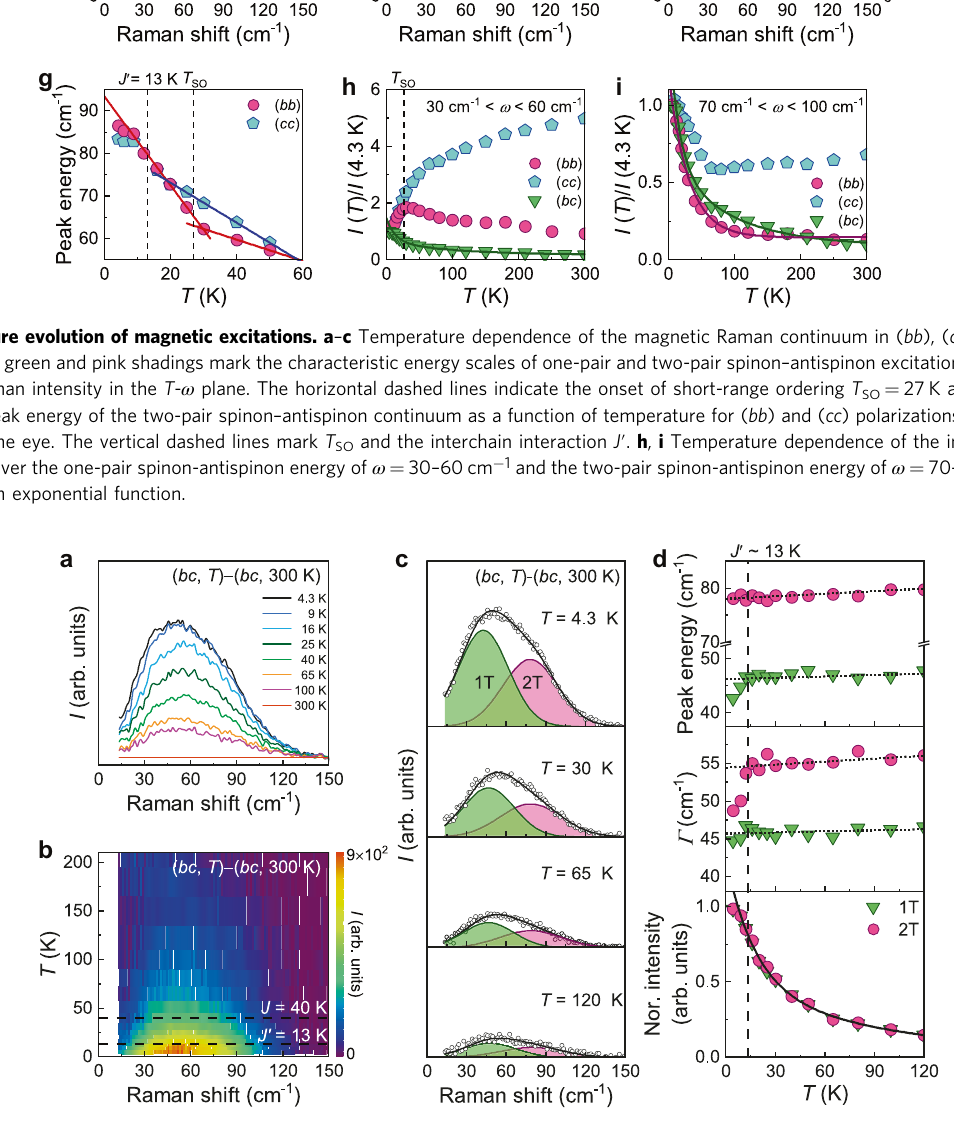
Fig. 4 Temperature evolution of one and two triplons in ( bc ) polarization. a Triplon signals in ( bc ) channel after subtraction of the T = 300 K spectrum. b Color plot of the subtracted triplon excitations in the T - ω plane. c Decomposition of the subtracted triplon excitations into one-triplon and two-triplon components at selected temperatures T = 4.3, 30, 65, and 120 K. d Temperature dependence of the peak energy, linewidth, and normalized intensity of the one (green inverse triangles) and two (pink circles) triplons. The triplons soften and narrow for the temperatures below T = J ’ as marked by the vertical dashed line. The solid line is fi t to the intensity as described in the main text. The dotted linear are guides to the